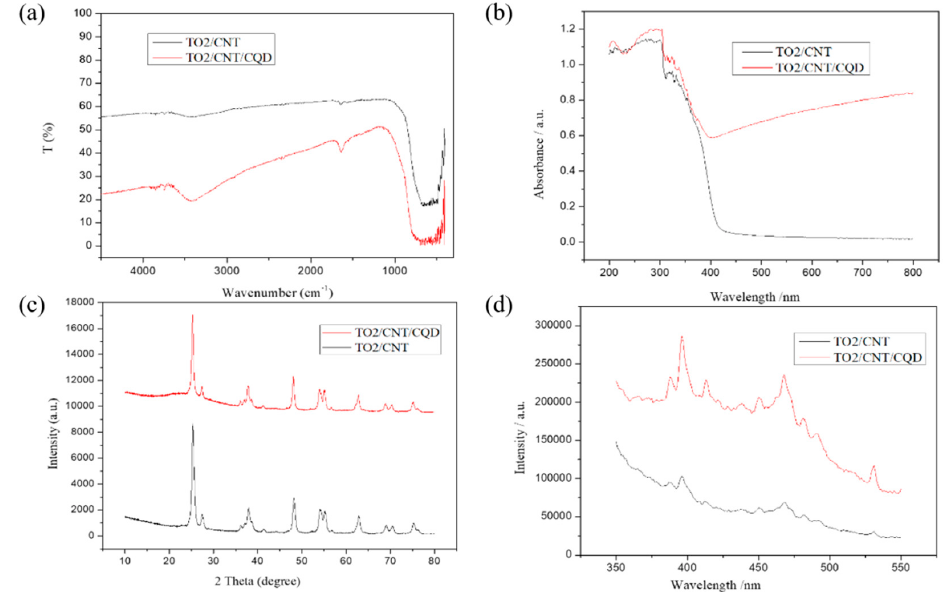
Figure 4. ( a ) FT-IR spectra, ( b ) UV–vis, ( c ) XRD patterns, and ( d ) photoluminescence spectra of TiO 2 /CNT and TiO 2 /CNT/CQD mesoporous composites. The FTIR spectra have indicated that the characteristic bands at 3400 cm − 1 and 1630 cm − 1 correspond to the surface water and hydroxyl group [45]. Figure 4 shows the XRD results of the TiO 2 /CNT/CQD mesoporous composite. As shown in Figure 4, it can be found that the TiO 2 /CNT/CQD mesoporous composite is an obvious anatase phase and C phase, which is conducive to improving the photoelectric properties of the material. TiO 2 nanoparticles have attracted great interest because of their special physical and chemical properties, especially as photocatalytic oxidation catalysts in corresponding device mate- rials and environmental pollution control [46]. Marine fouling is a critical issue in modern marine science and technology, which strictly determines marine transportation and farming. The existing antifouling ap- proaches, such as antifouling hydrogel coatings and organic tin coating [47–49], always demonstrate an unsatisfactory performance. In our system, the material shows the CV curves and anti-bacterial properties of the control, TiO 2 /CNT and TiO 2 /CNT/CQD, using Escherichia coli bacteria (Figure 5). Comparing the bacteriostasis processes uses TiO 2 /CNT (Figure 5c) and TiO 2 /CNT/CQD (Figure 5d) as anti-bacterium agents, respectively. In this experiment, obviously, the number of Escherichia coli bacterial colonies in Petri dishes all increased with time. The sample (c) with TiO 2 /CNT/CQD as an anti-bacterium agent got the bacterium of Escherichia coli under control, while the sample using TiO 2 as an anti- bacterium agent just grew more bacterial colonies, indicating that doping TiO 2 with CNT and CQD contributes to boosting the TiO 2 s performance in an environmental pollution control.